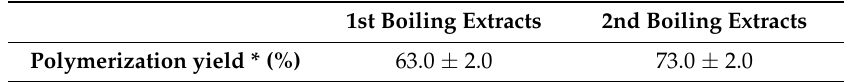
Table 4. The polymerization yield after the incubation of the liquid extracts with laccase.